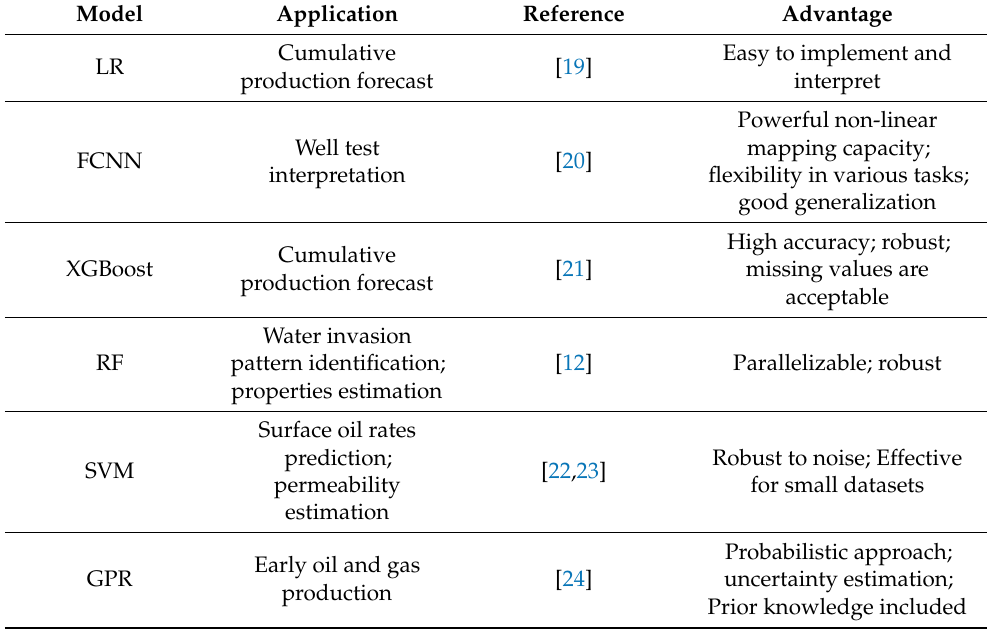
Table 1. Commonly used ML model in reservoir